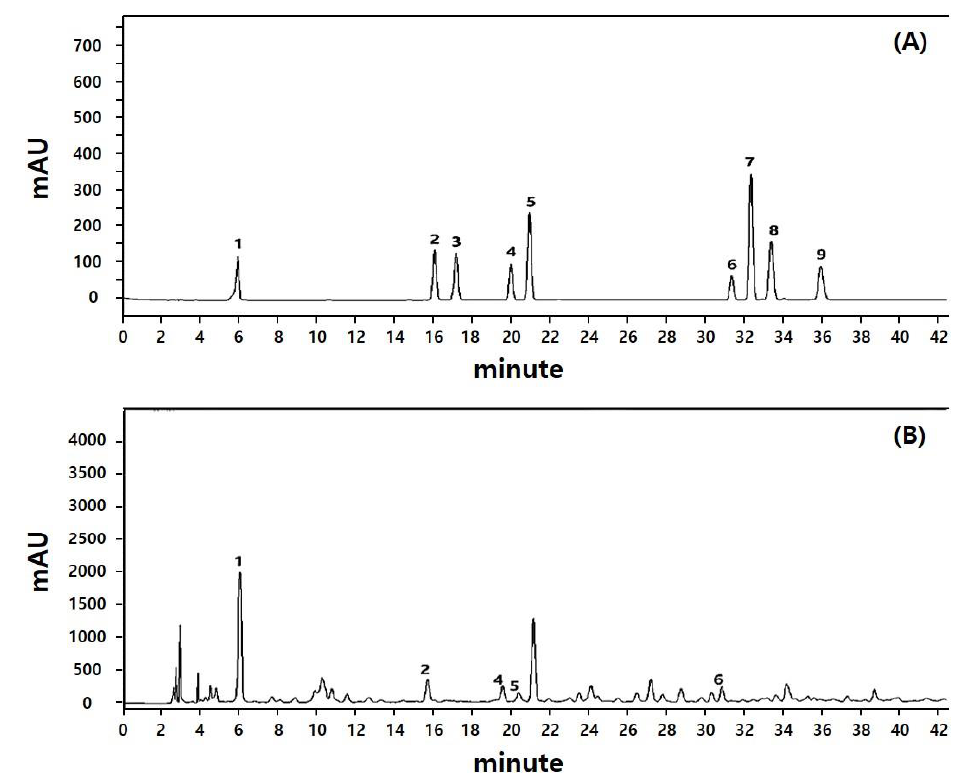
Figure 1. HPLC chromatograms of the phenolic acid standard mixture ( A ) and profiles of SBP extract ( B ). 1. gallic acid, 2. p-hydroxybenzoic acid, 3. methyl gallate, 4. vanillic acid, 5. caffeic acid, 6 ferulic Table 2. The content of free phenolic compound in SBP Table 1. Radical scavenging capacity and phytochemicals in sword bean pod.